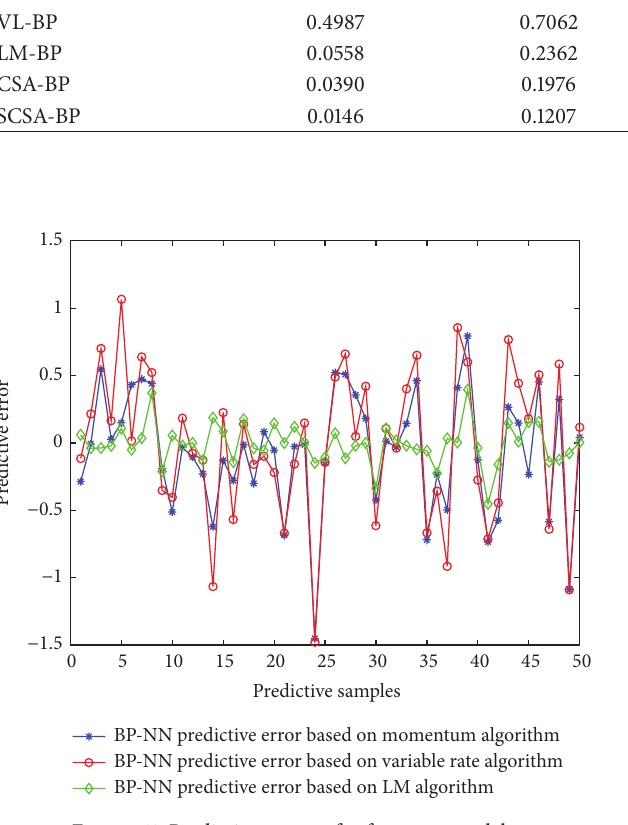
Figure 11: Predictive errors of soft-sensor model.